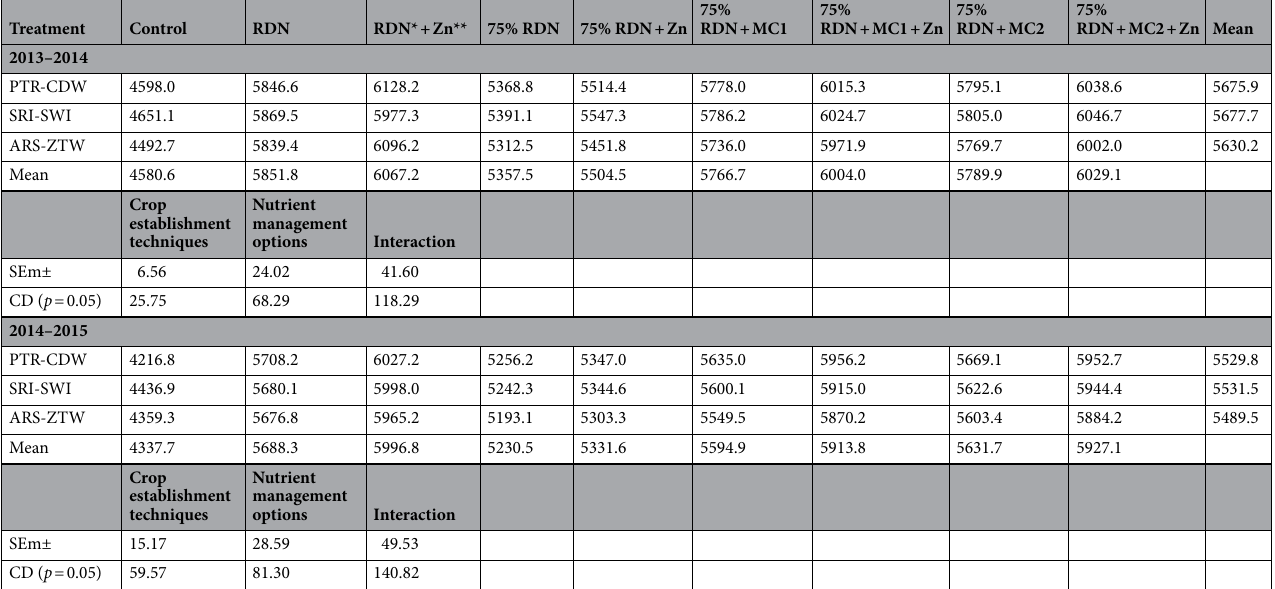
Table 6. Influence of crop establishment techniques and nutrient management options on iron uptake (g ha −1 ) in rice–wheat cropping system during 2013–2014 and 2014–2015. PTR , puddled transplanted rice; SRI , system of rice intensification; ARS , aerobic rice system; CDW , conventional drill-sown wheat; SWI , system of wheat intensification; ZTW , zero tillage wheat; RDN* , recommended dose of nutrients [120 kg nitrogen ha −1